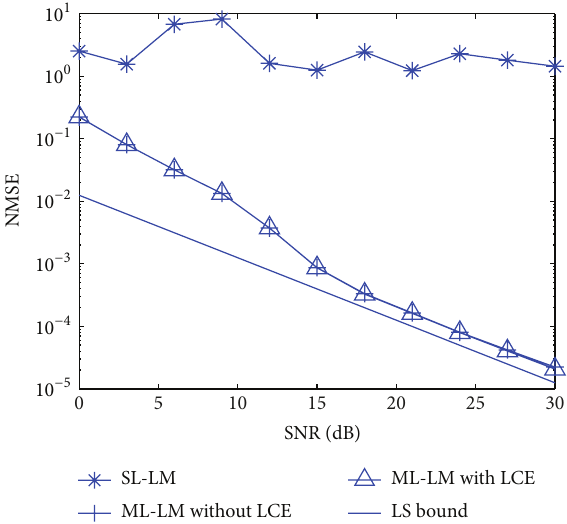
Figure5:NMSEcomparisonsofSL-LMandML-LMiterationwhen 𝐿 = 20 (with and without LCE).